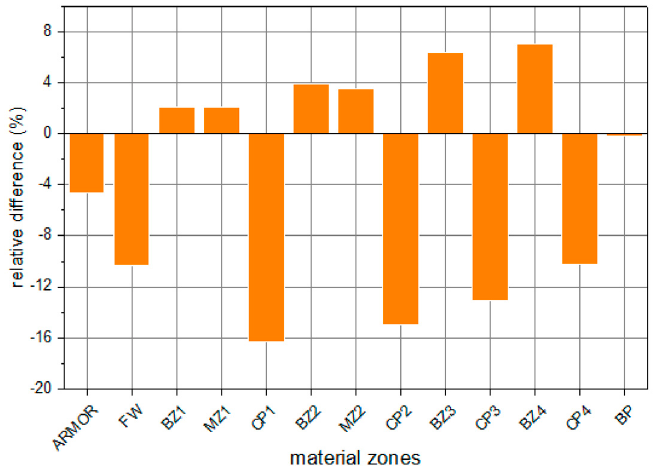
Figure 20. The relative differences of power density between the one-way and two-way N/TH coupling calculations.